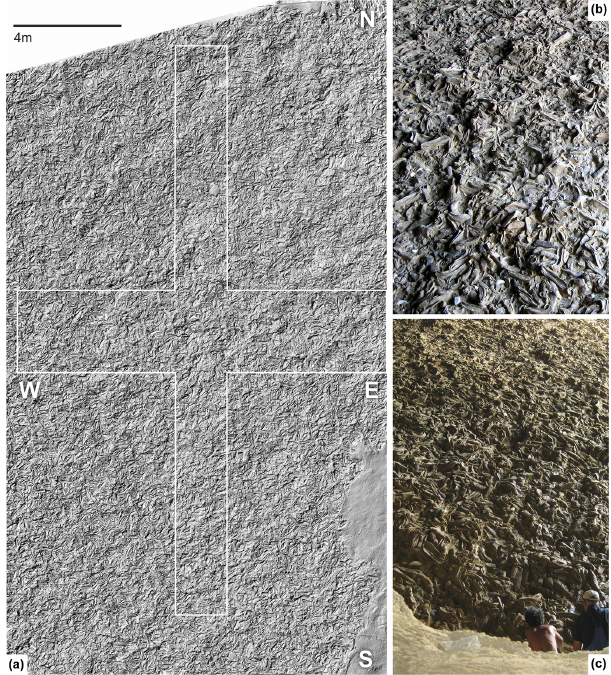
Figure 1. Part of the digital surface model of the shell bed; the white cross indicates the area, within which all objects were dig- itally outlined and evaluated. It contains 1121 complete shells of C. gryphoides and 7047 fragments of that species (a) . Outcrop pic- tures of the shell bed illustrating the density and extent of the shell bed (b–c) , (b) width ca. 2m; (c) see workers as scale.